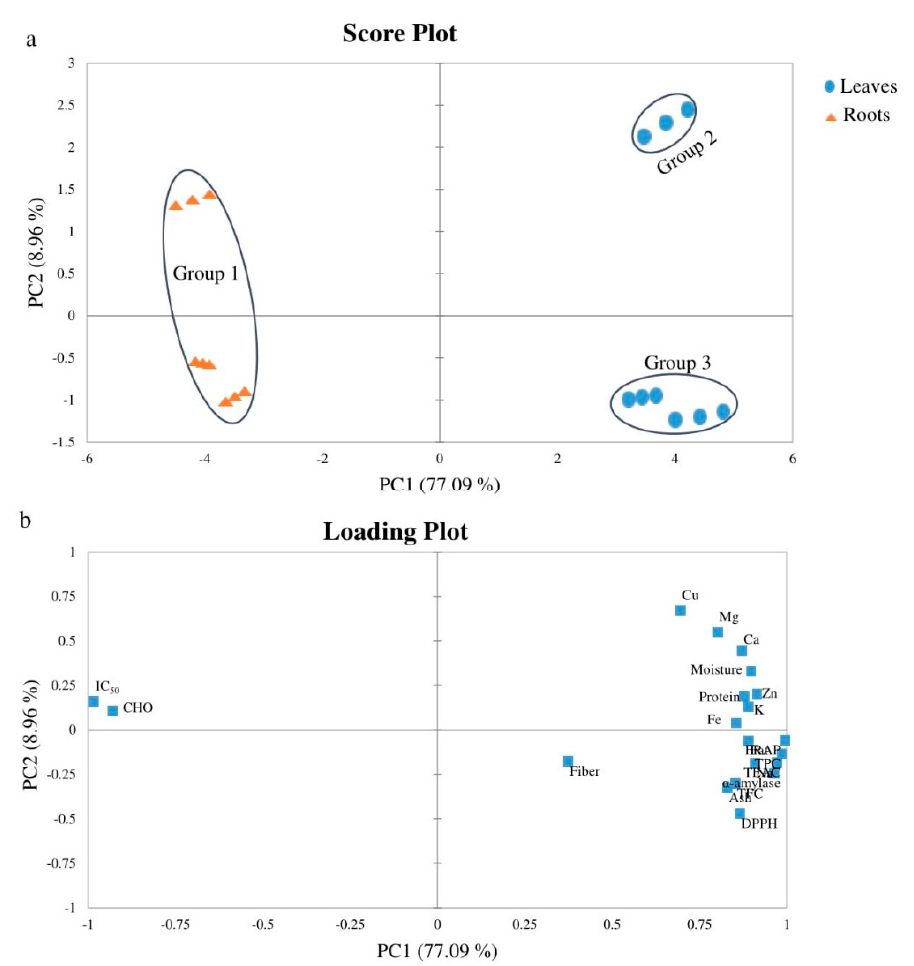
Figure 4. Score ( a ) and loading ( b ) plots of PCA analysis for the first and second components of selected plants.